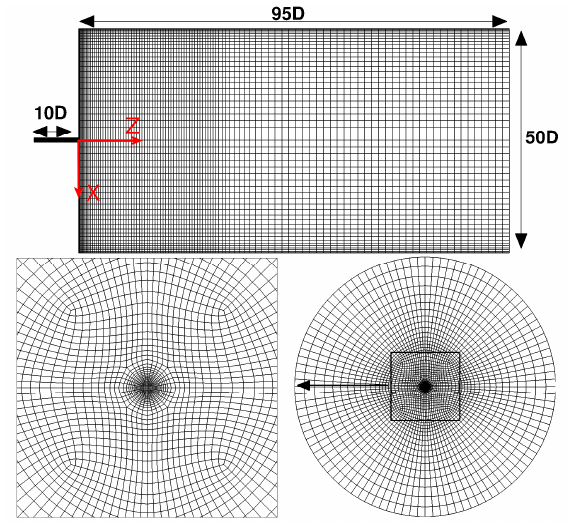
Figure 1. Computational domain and mesh structure.